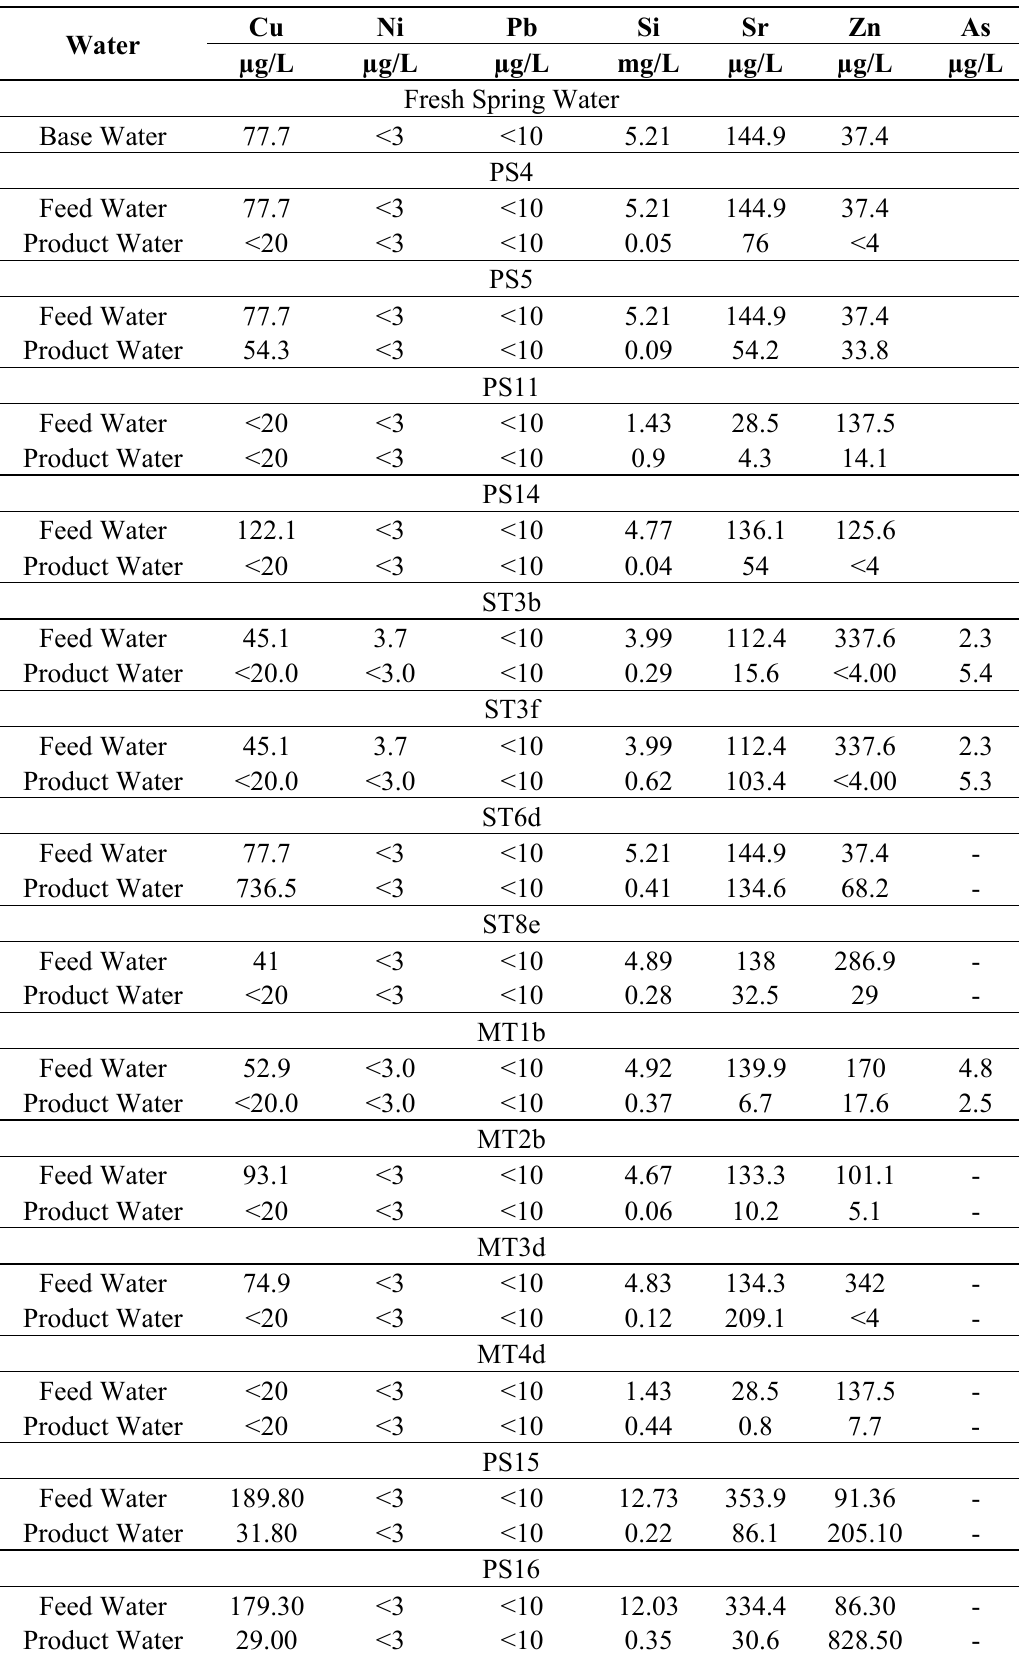
Table C4. Measured Cation Concentrations in the Feed and Product